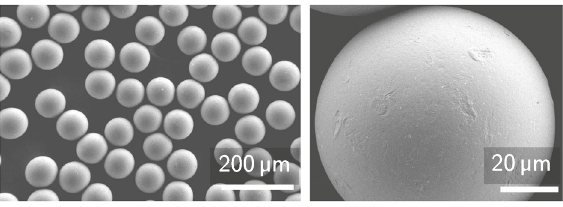
Fig. 8 Scanning electron microscopy of the granular material used. The micrographs presented are taken in-house after the completion of the cleaning process.